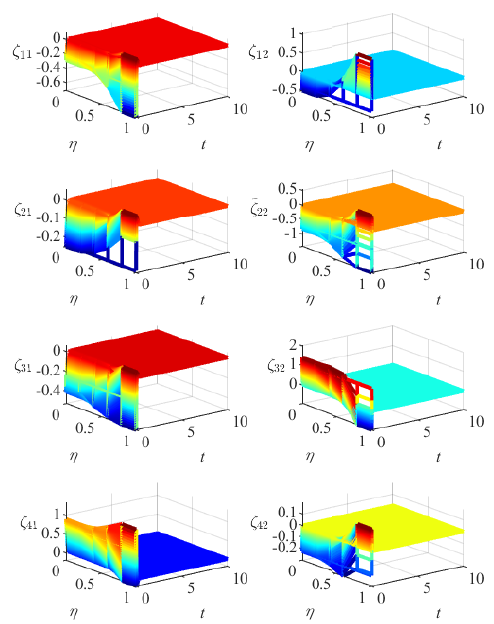
Figure 5. The system error ζ i ( η , t ) of MAS with boundary coupling (5) in Example